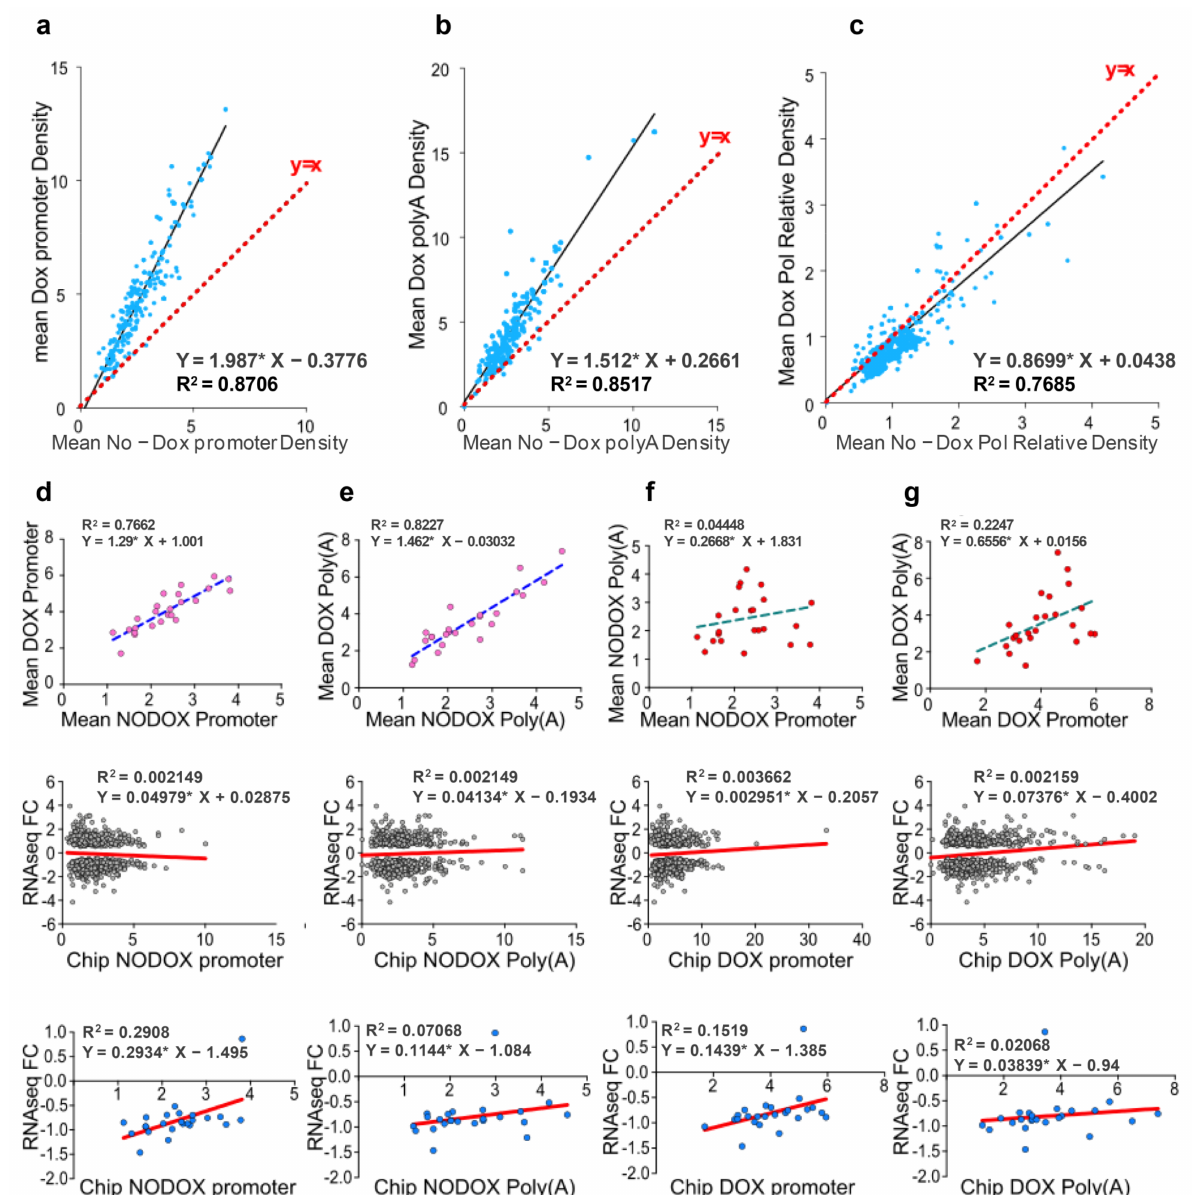
Figure 5. MYC inhibition affects RNAPII density at promoter and terminator regions. Correla- tion scatter plots of RNAPII occupancy and mRNA fold change (FC) in genes strongly expressed (FPKM ≥ 10) in at least one condition and with a significant Fold Change ( p -value threshold < 0.05) in BT168FO cells treated or not with DOX for 48 h. First two rows ( a – g ): RNAPII density at pro- moter and PolyA regions; ( a – c ): all MYC target genes; ( d – g ): Muhar signature genes (the same as in Figure 4e). The scatter plots show an increased RNAPII occupancy upon Omomyc induction at both promoter and termination sites, slightly higher at promoters. Third and fourth rows: comparison between RNAseq Fold Change and CHIPseq density at promoters and terminators. Third row: all MYC targets; fourth row: Muhar signature genes (as in Figure